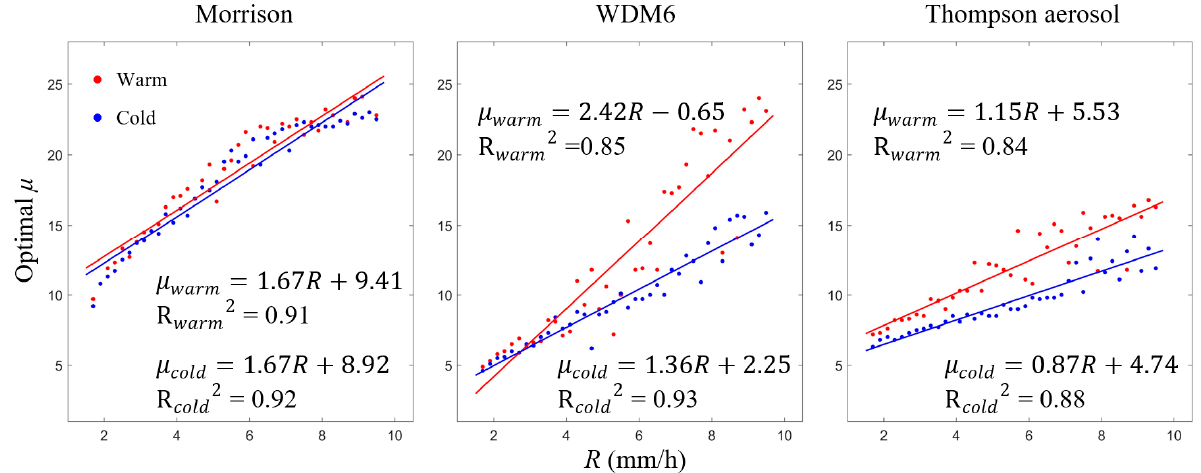
Figure 8. Optimal μ of different rain rates and fittings curves by season and double-moment Figure 8. Optimal µ of different rain rates and fittings curves by season and double-moment schemes. schemes. Table 2. Adaptive- µ models of the gamma RSD distribution in the WRF double-moment bulk microphysical parameterizations of different